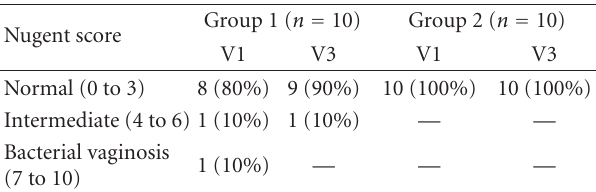
Table 1: Changes in Nugent